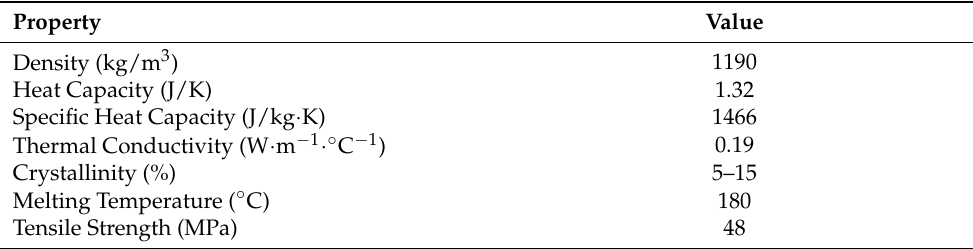
Table 1. Physical and mechanical properties of the PMMA for laser welding.